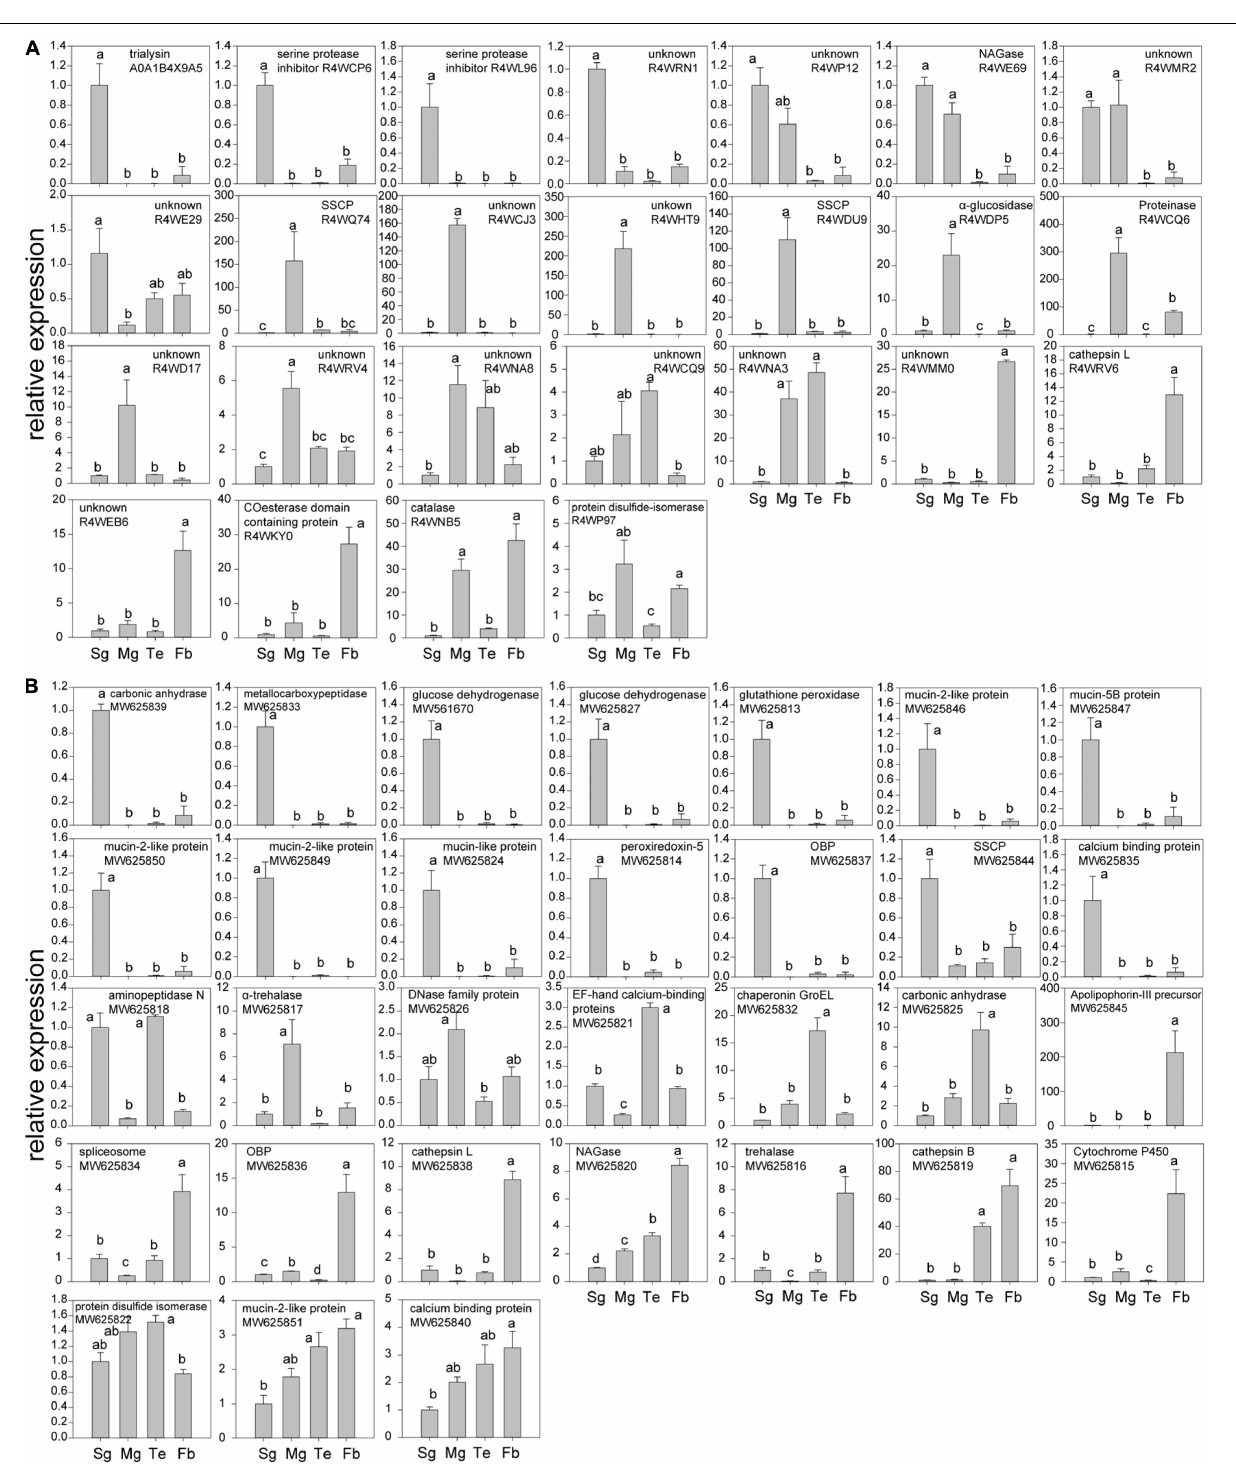
Frontiers in Ecology and Evolution |